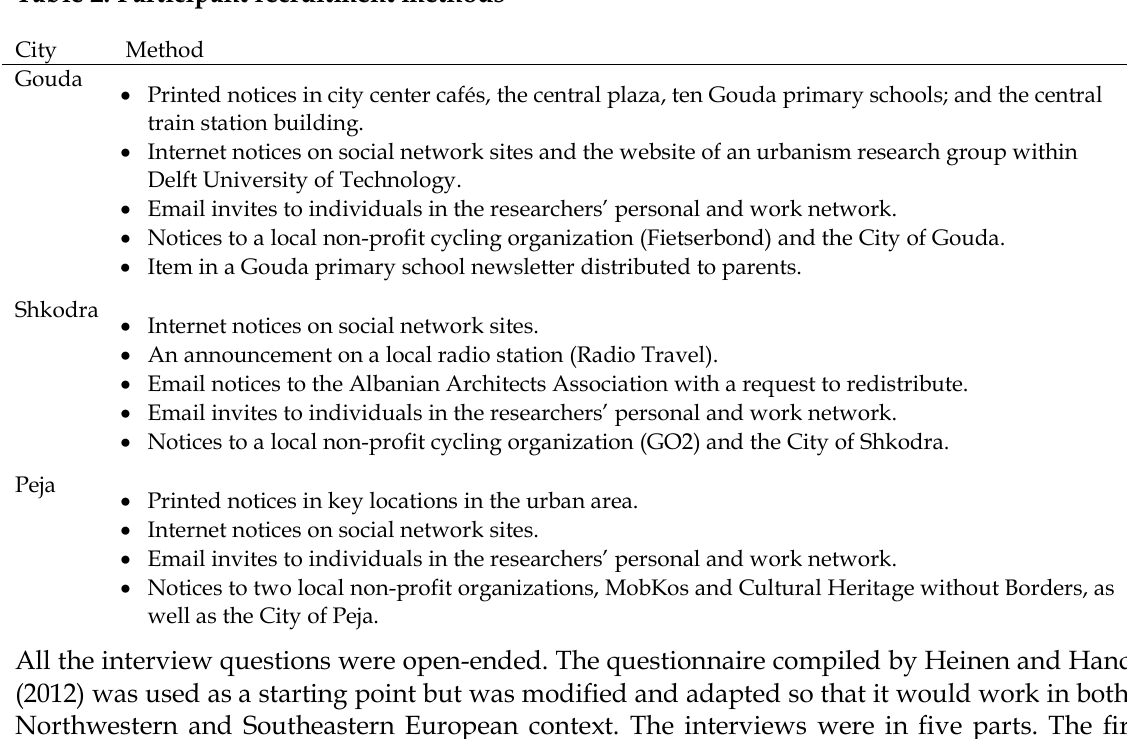
Table 2. Participant recruitment